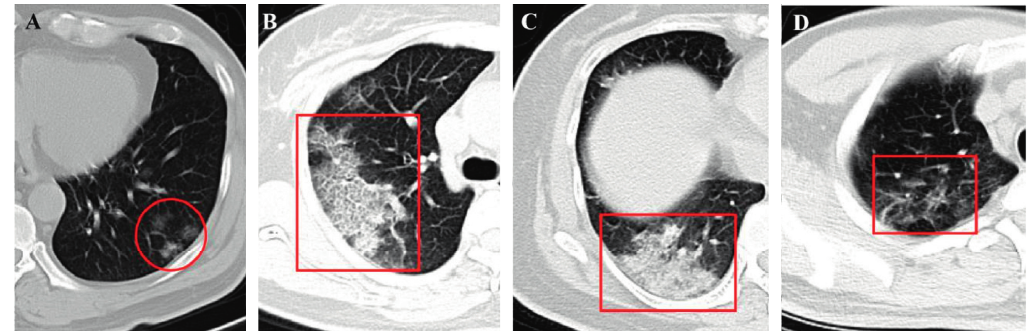
Figure 1: (a) A 46-year-old male COVID-19 patient with no obvious symptoms. CT scan shows three GGOs in the left lower lobe (red cycle). (b) A 46-year-old female COVID-19 patient with fever for 1 day. CTscan demonstrates crazy-paving pattern in the right upper lobe (red rectangle) (5 days after the onset of initial symptoms). (c) The same patient in (b) and the follow-up CTshows the consolidation in the right lower lobe (red rectangle) (8 days after the onset of initial symptoms). (d) A 38-year-old male COVID-19 patient with initial symptoms of dry cough and fatigue for 10+ days. CTscan shows the interlobular septal thickening in the right lower lobe (red rectangle) (7 days after the onset of initial symptoms). Table 2: The most frequent CT findings acquired from the published